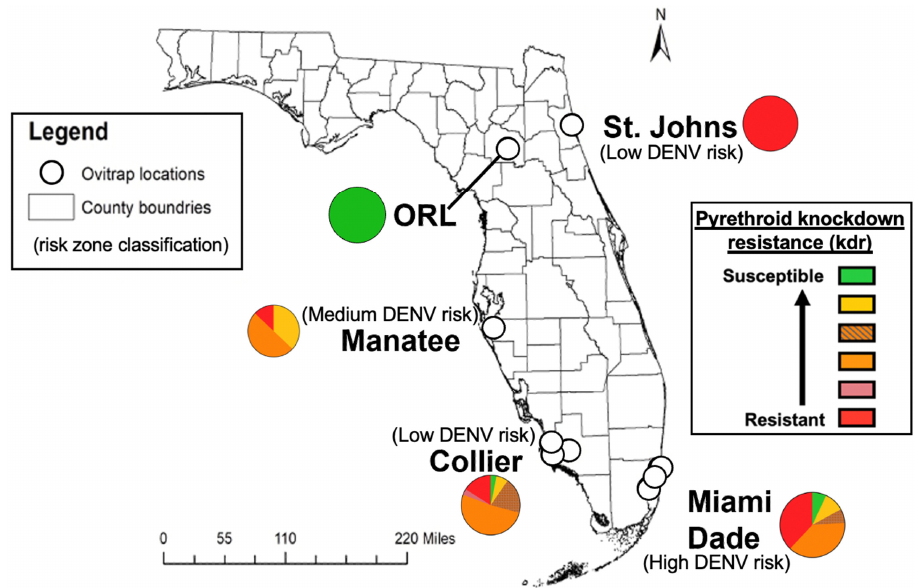
Figure 1. Aedes aegypti collection locations for four field-derived colonies from different historical DENV risk zones and one laboratory colony in Florida, USA., with reported kdr genotype frequency distributions for pyrethroid insecticide resistance shown as part-of-whole graphs.